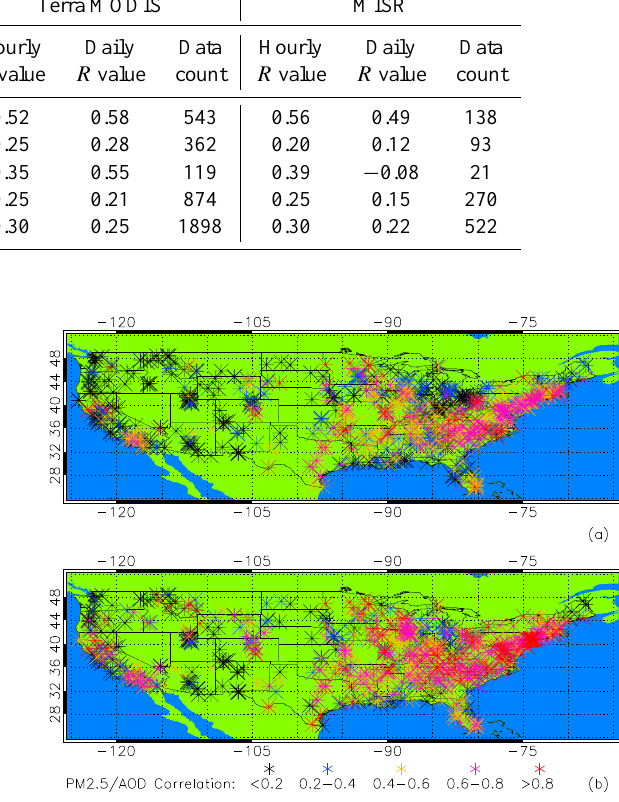
Figure 4. For the period 2008–2009, the US EPA daily PM 2 . 5 sites used in this study. Sites are color-coded based on the correlation between daily PM 2 . 5 observations and daily 1 ◦ × 1 ◦ (a) operational and (b) DA Terra MODIS AOD.